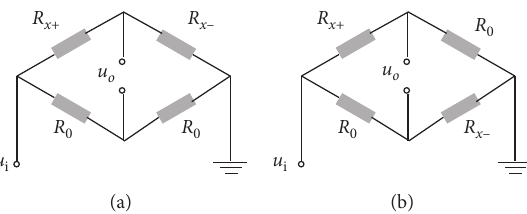
Figure 11: Structure of the Wheatstone bridges to measure the (a) bending strain and (b) axial